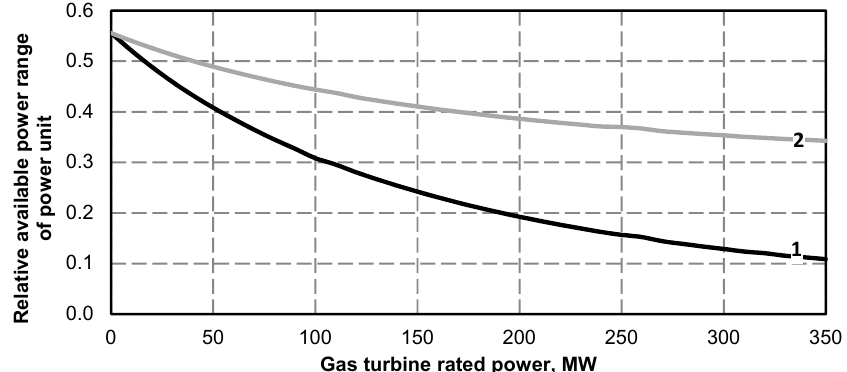
Figure 39. Steam turbine power as a function of gas turbine rated power: 1 –fixed stream of 319.4 kg/s fresh steam fed to steam turbine; 2 — minimum steam boiler output of 133.3 kg/s and for gas turbine operating at a rated power, 2’— minimum steam boiler output of 133.3 kg/s and gas turbine operating with 60% of its rated power, 3 — 40% of gas turbine rated power.